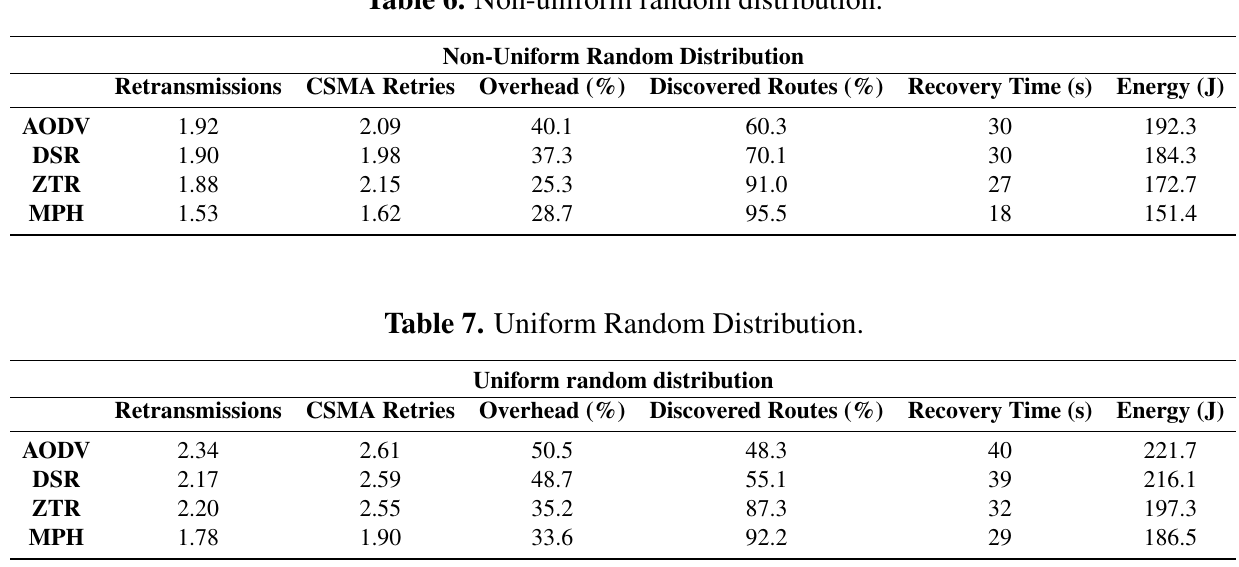
Table 6. Non-uniform random distribution.